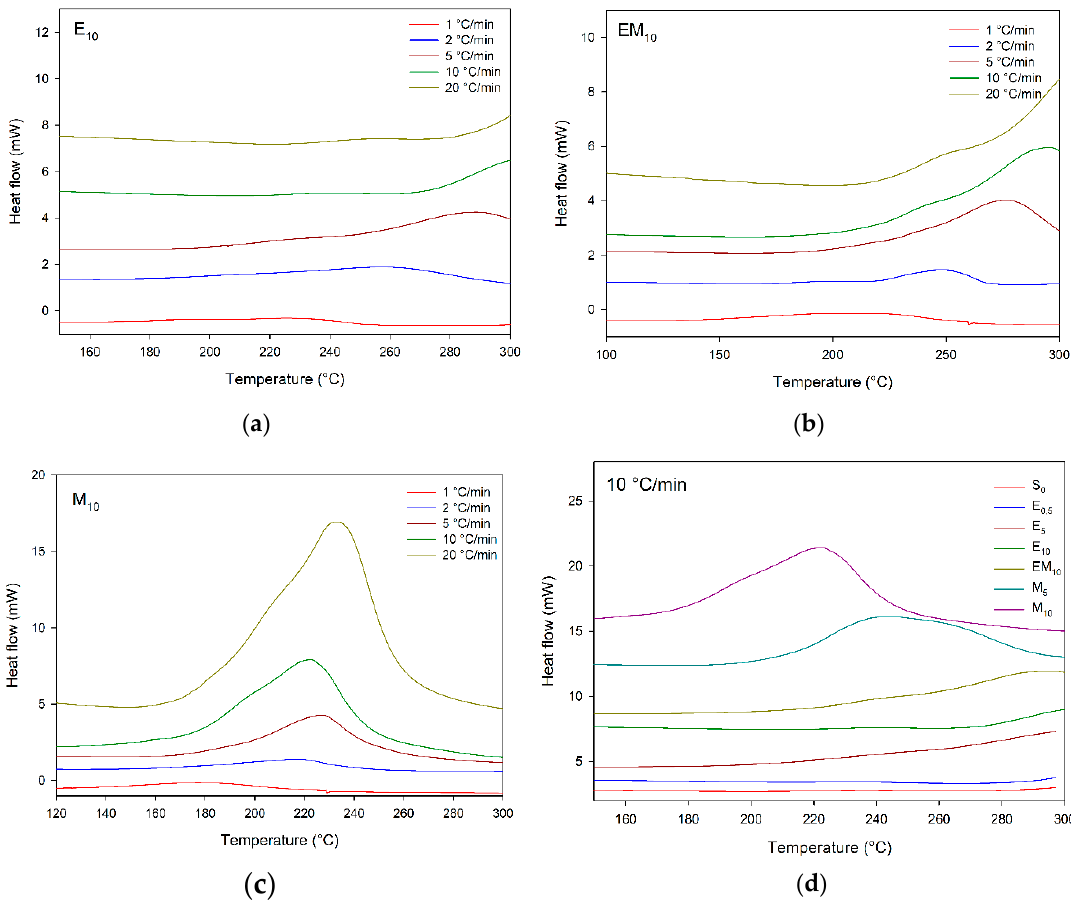
Figure 6. DSC scans of E X /EM X /M X ( a ) E 10 , ( b ) EM 10 , ( c ) M 10 , and ( d ) DSC acquired at 10 °C/min, compounds indicated. Table 5. Cure parameters M X 100:87:X.